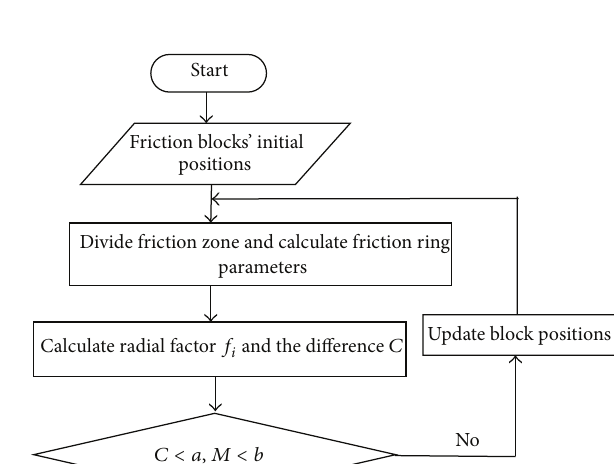
Table 6: Areas of friction rings.